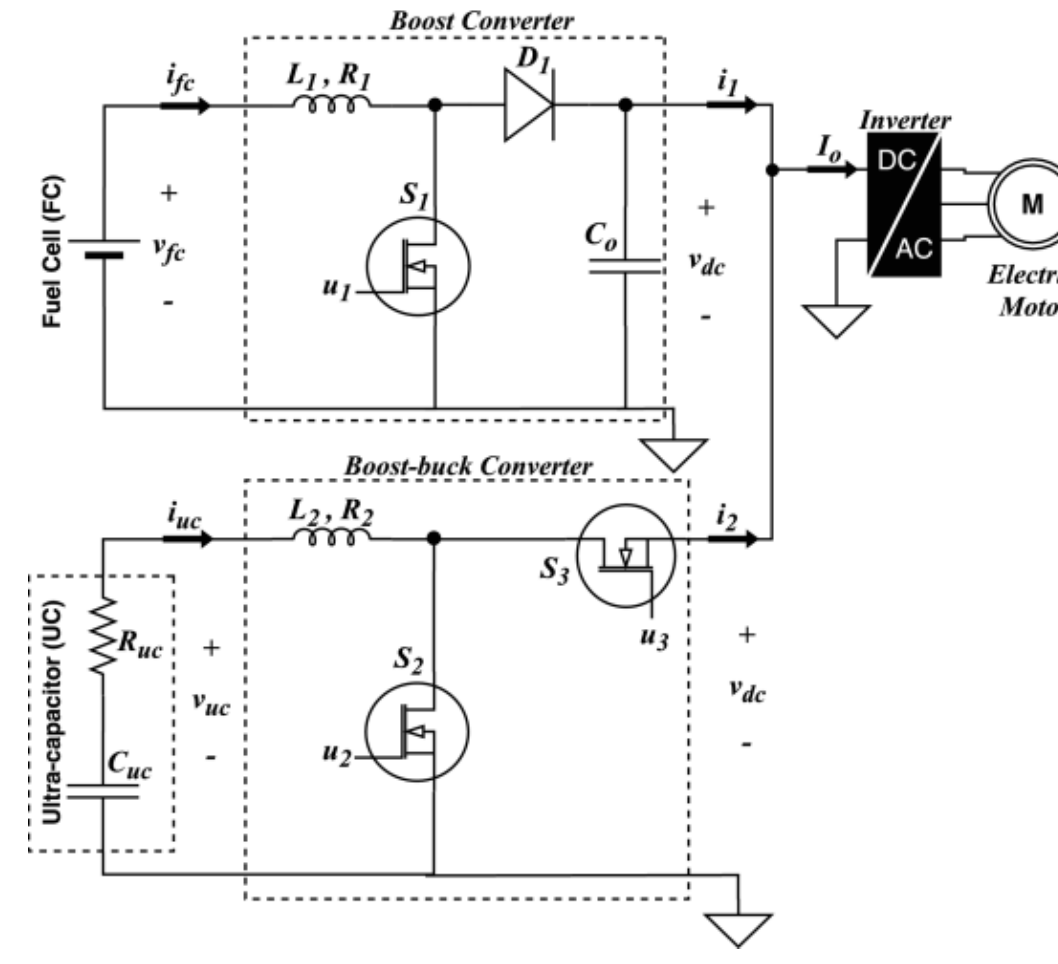
Figure 1. Power stage schematic of the HEV